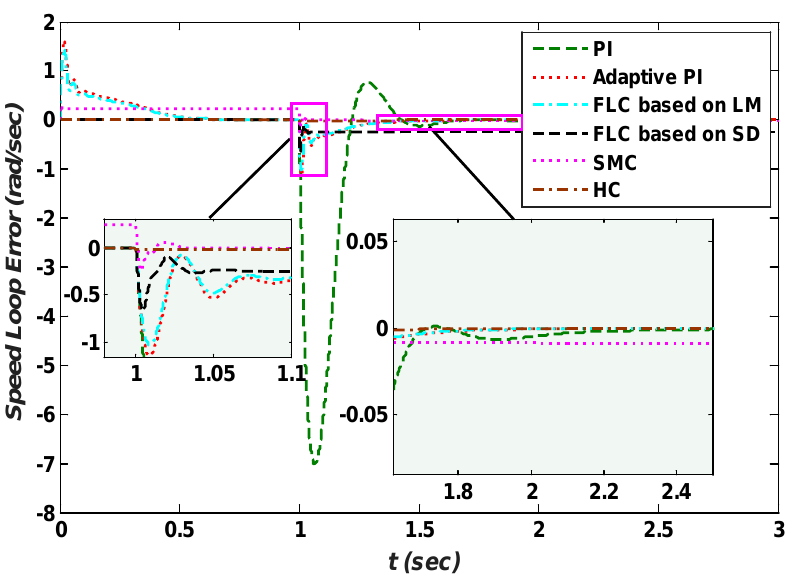
Figure 22. The speed loop error response for designed control schemes.